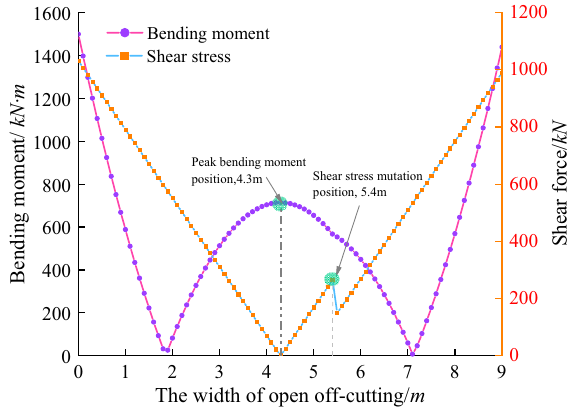
Figure 5. Distribution of bending moment and shear force along coal